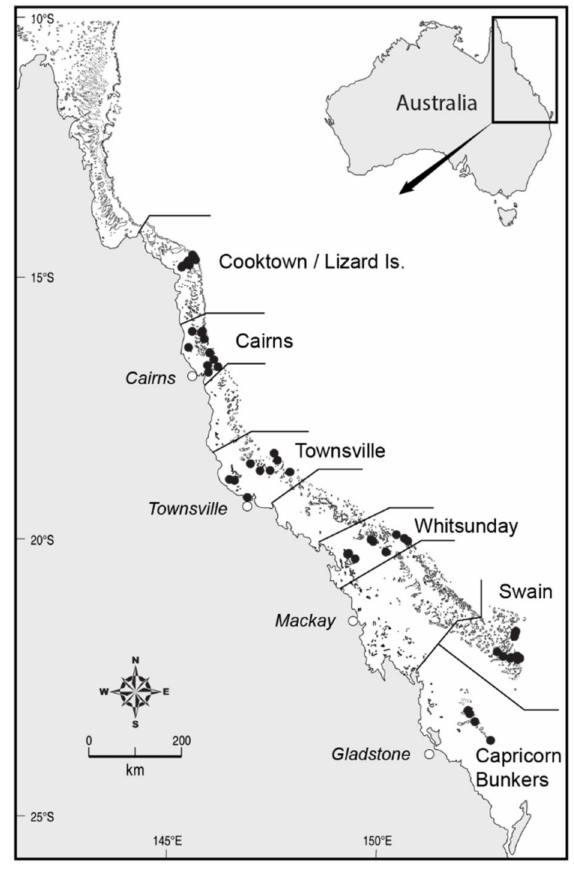
Figure 1. Location of the survey reefs on the Great Barrier Reef spread across six latitudinal sectors and three shelf